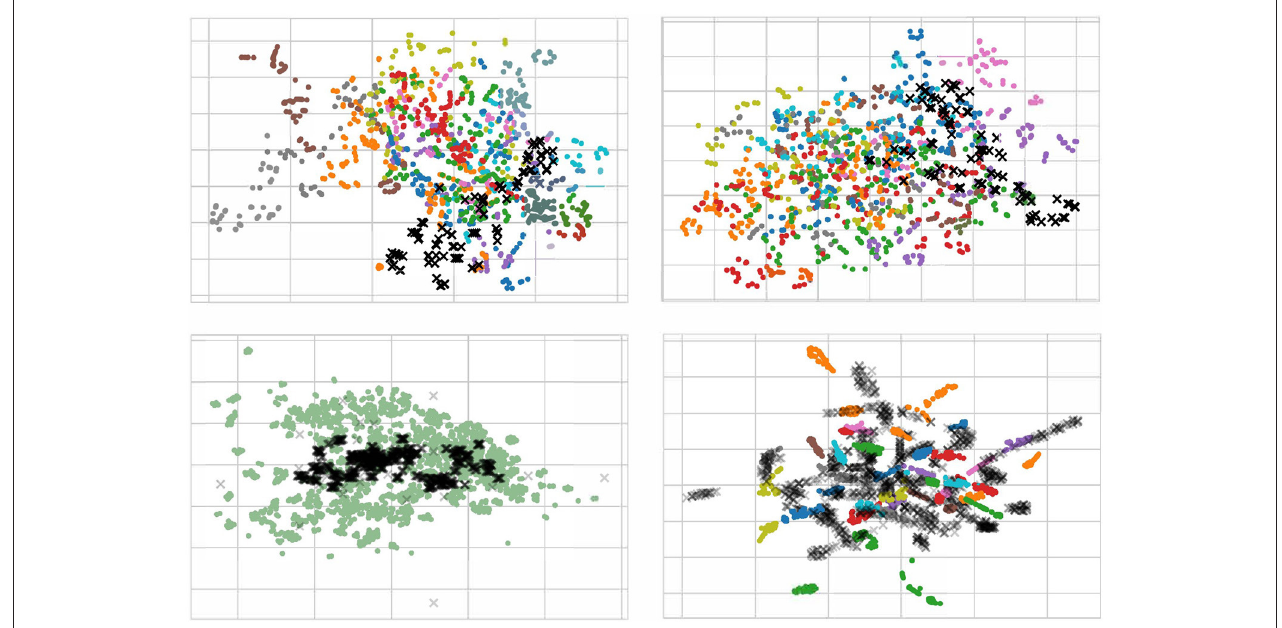
FIGURE 9 | Visualization with t-SNE for raw data (upper left), normalization data (upper right), data using DAN (lower left), and data using MS-MDA (lower right). The input data of the last fully-connected (DSC) layer are used for the computation of the t-SNE. Target data are in the shape of X with black, all other 14 source data are in 14 colors. Notice that since we have concatenated all the source domains, the lower left figure has only one color for the source domain. All four figures are best viewed in